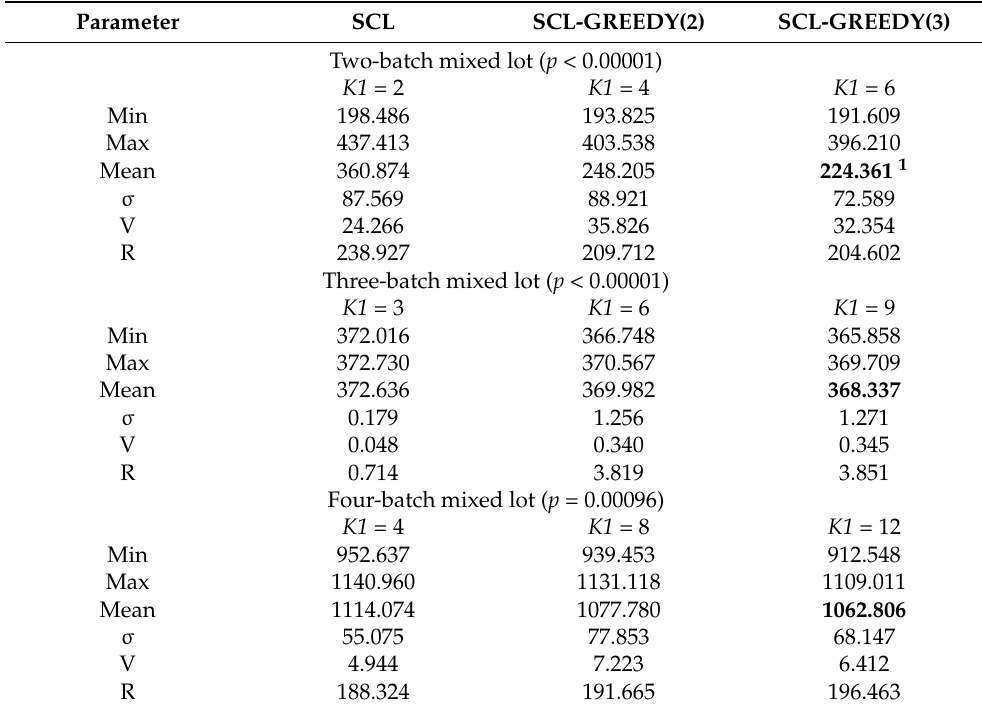
Table 5. Objective function value summarized after 30 attempts (Manhattan